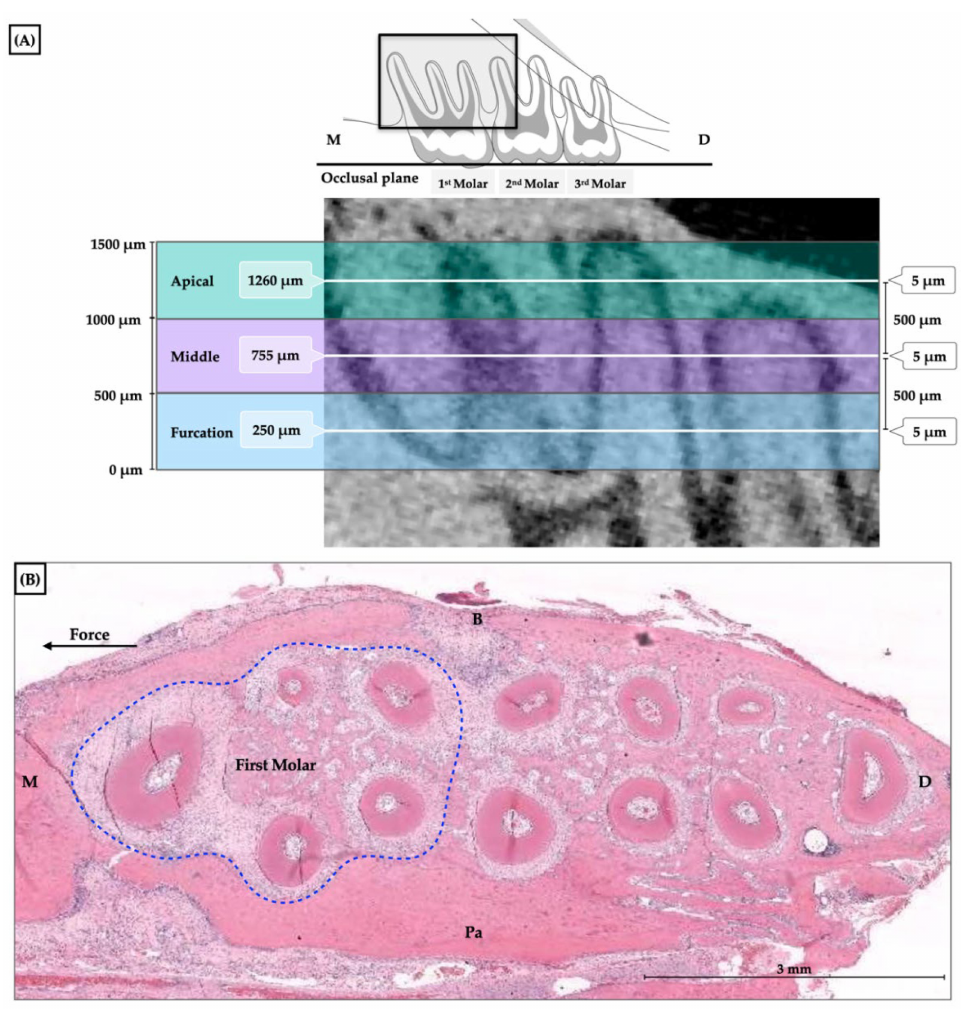
Figure 3. The histological sections. ( A ) The three levels of roots: cervical, middle, and apical levels with 5 µ m in thickness at 500 µ m intervals; ( B ) The hematoxylin and eosin-stained histological sections. M = mesial, D = distal, B = buccal, P =